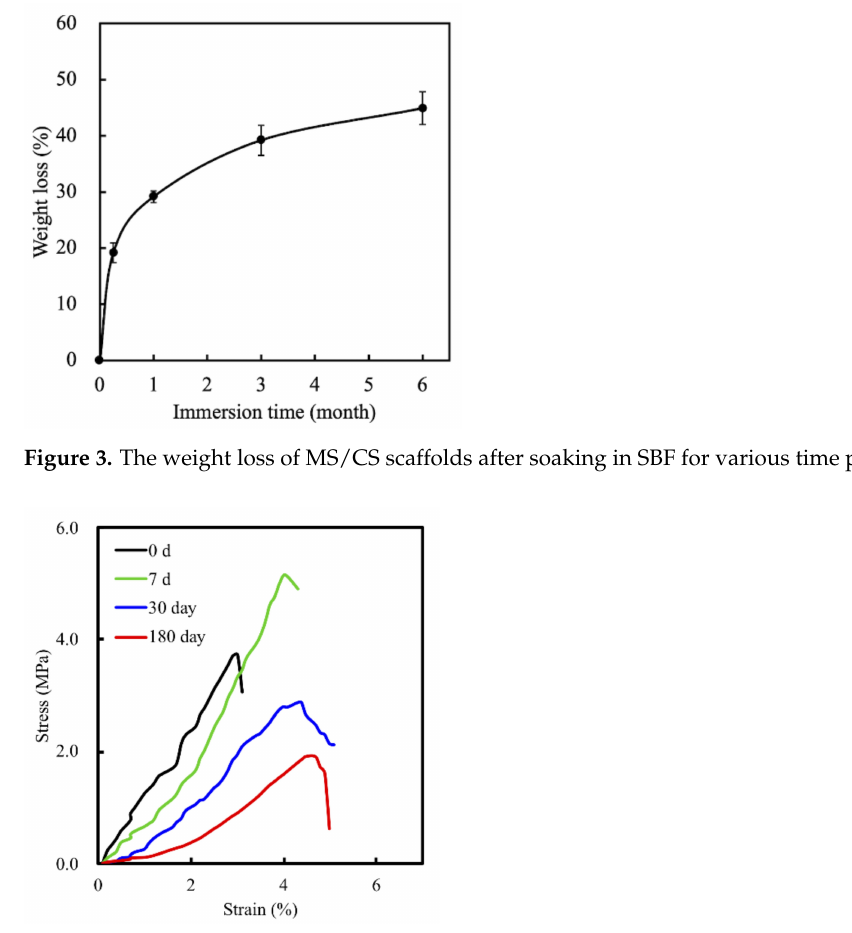
Figure 4. Stress–strain curve of the MS/CS scaffold after immersion in SBF for 7, 30, and 180